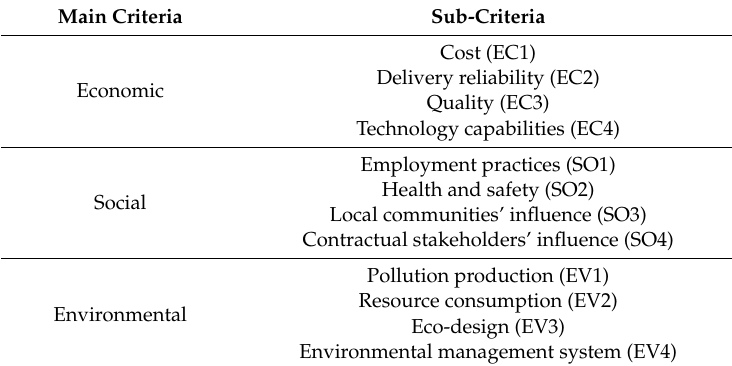
Table 2. List of all main and sub-criteria a ff ecting sustainable fabric supplier